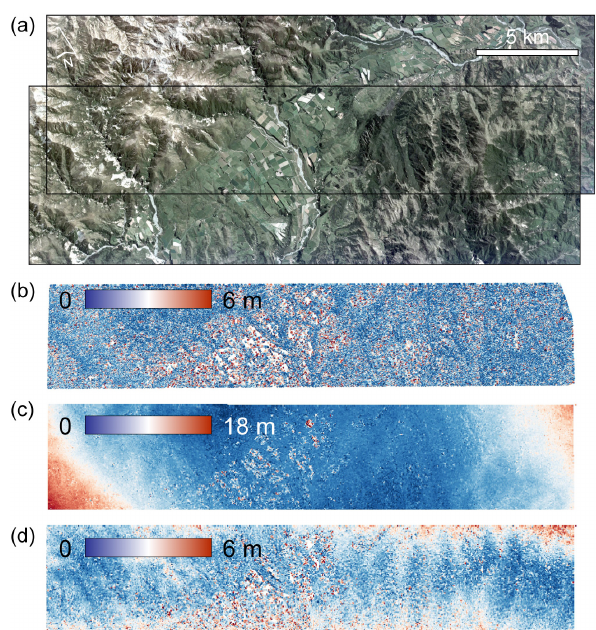
Figure 9. Horizontal surface displacements from PlanetScope im- ages of 20–25 November 2016 without surface motion; total mag- nitude of displacement. (a) The two scenes and their overlap are matched in (b) – (d) . (b) Displacements between orthorectified ver- sions. (c) Displacements between the unrectified versions, when coregistered using a first-order polynomial. (d) As in (c) but coreg- istered using a second-order